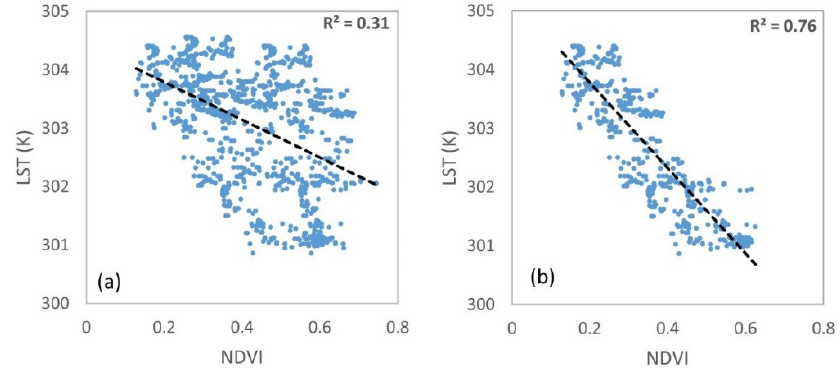
Figure 6. Example of MODIS land surface temperature (LST)–NDVI ( a ) before and ( b ) after the proposed modification.